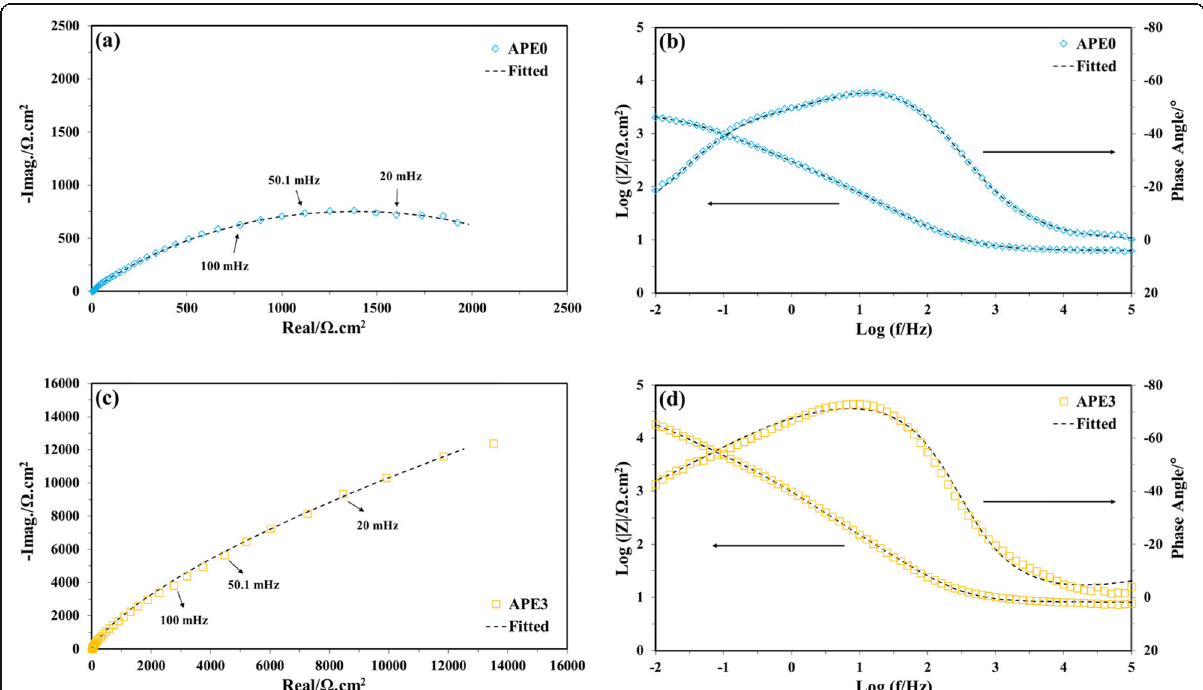
Fig. 7 Nyquist curves (a, c) and Bode curves (b, d) with the fitted curves for steel sample after 7-day immersion in NaCl brine containing 0% (v/v) of APE (APE0) and 3% (v/v) of APE (APE3)